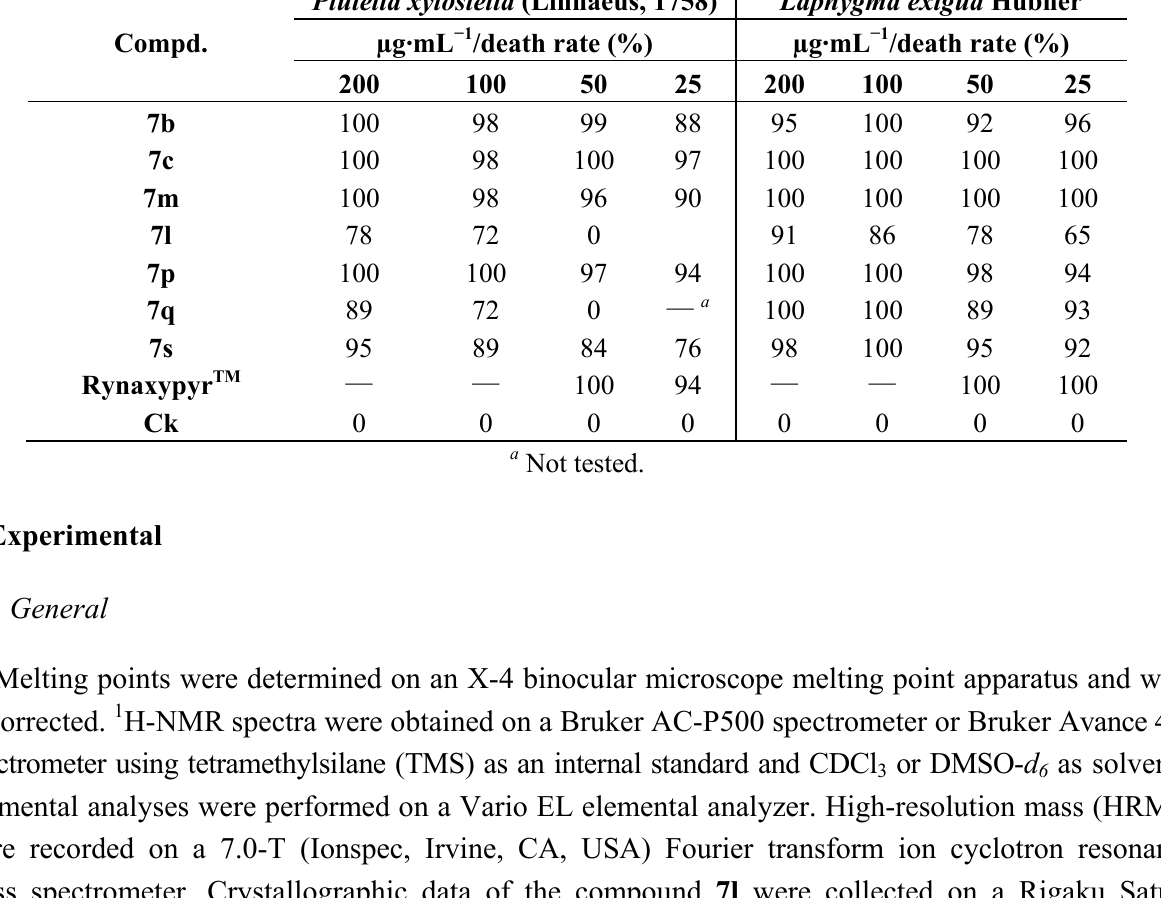
Table 3. Insecticidal activity against Plutella xylostella (Linnaeus, 1758) and Laphygma exigua Hübner of title compounds (mortality/%). Plutella xylostella (Linnaeus, 1758) Laphygma exigua Hübner Compd. µg·mL − 1 /death rate (%)